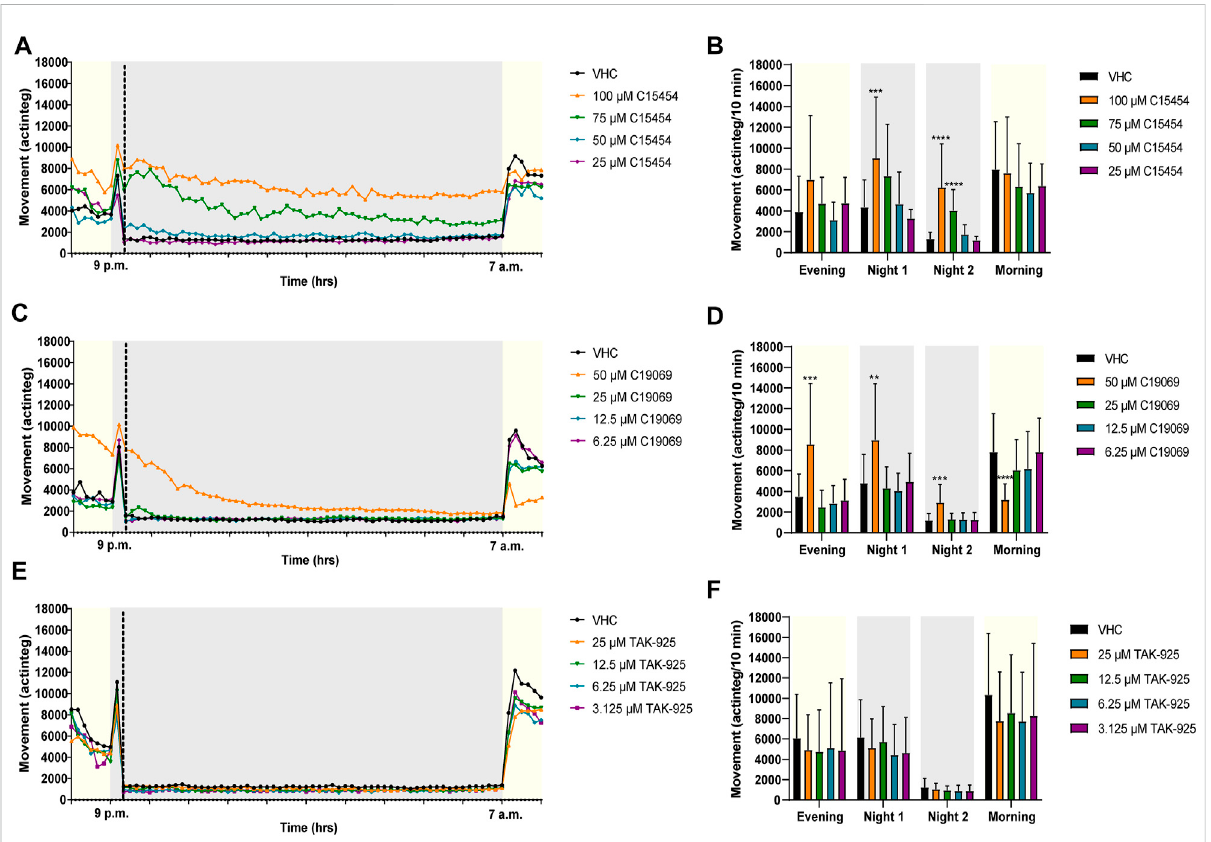
FIGURE 5 Behavioral analysis of 6 dpf zebra fi sh larvae treated with orexin 2 receptor agonists in the night assay. Locomotor pro fi les of animals are expressed as mean actinteg units per 10 min treated with C15454 (A) , C19069 (C) and TAK-925 (E) are plotted as function of time. Different phases are shown, i.e. the light phase from 8 p.m. to 9 p.m. (i.e., Evening), the fi rst dark phase from 9 p.m. to 9:20 p.m. (i.e., Dark 1), the second dark phase from 9:20 p.m. to 7 a.m. (i.e., Dark 2), and the light phase from 7 a.m. to 8 a.m. (i.e., Morning). For the sake of clarity, standard deviations are not shown. Total locomotor activity was averaged (±SD) per respective light or dark phase (B – F) . For each compound, data were pooled from three or fourindependentexperimentswith7 – 10replicatewellspertestcondition( n =23 – 30,exceptfor75 µMC15454( n =20)and25 µMC15454( n